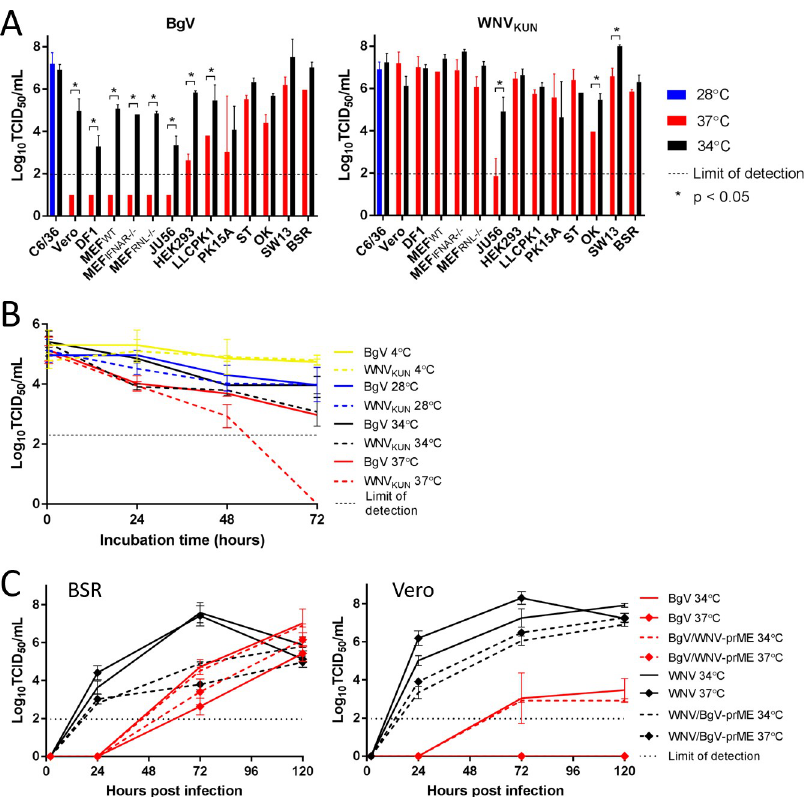
Fig 2. A. Replication of BgV and WNV KUN in vertebrate cells. Cells were inoculated at MOI 1 with BgV or WNV KUN in triplicate for 1h 30min, the inoculum removed and the cells washed before incubating at 34˚C (black), 37˚C (red) or 28˚C (blue) with fresh medium. The inoculated cell culture supernatants were harvested five days p.i., titrated on C6/ 36 cells and analysed by fixed-cell ELISA. The dotted line represents the lower limit of detection, � stands for p < 0.05. Error bars represent the standard deviation. B. Thermostability of BgV and WNV KUN at various temperatures over three days. Triplicates of 10 5 TCID 50 IU of BgV and WNV KUN were held at 4˚C, 28˚C, 34˚C and 37˚C in culture medium with 2% FBS in the absence of cells, harvested at 30min, 24h, 48h and 72h after the start of incubation and stored at -80˚C. These samples were titrated on C6/36 cells and the titres determined by fixed-cell ELISA. Error bars represent the standard deviation. C. Replication kinetics of BgV, BgV/WNV-prME, WNV KUN and WNV/BgV-prME, in BSR (left) and Vero cells (right) over five days at 34˚C and 37˚C. The cells were inoculated at MOI 0.1 in triplicates at 34˚C or 37˚C for 1h 30min, the inoculum removed and the cells washed before incubating at either temperature with fresh medium. The supernatants were harvested at 2, 24, 72 and 120 hours p.i., stored at -80˚C until they were titrated on C6/36 cells and the titres determined by fixed-cell ELISA. Error bars represent the standard deviation and the dotted lines represent the lower limit of detection.